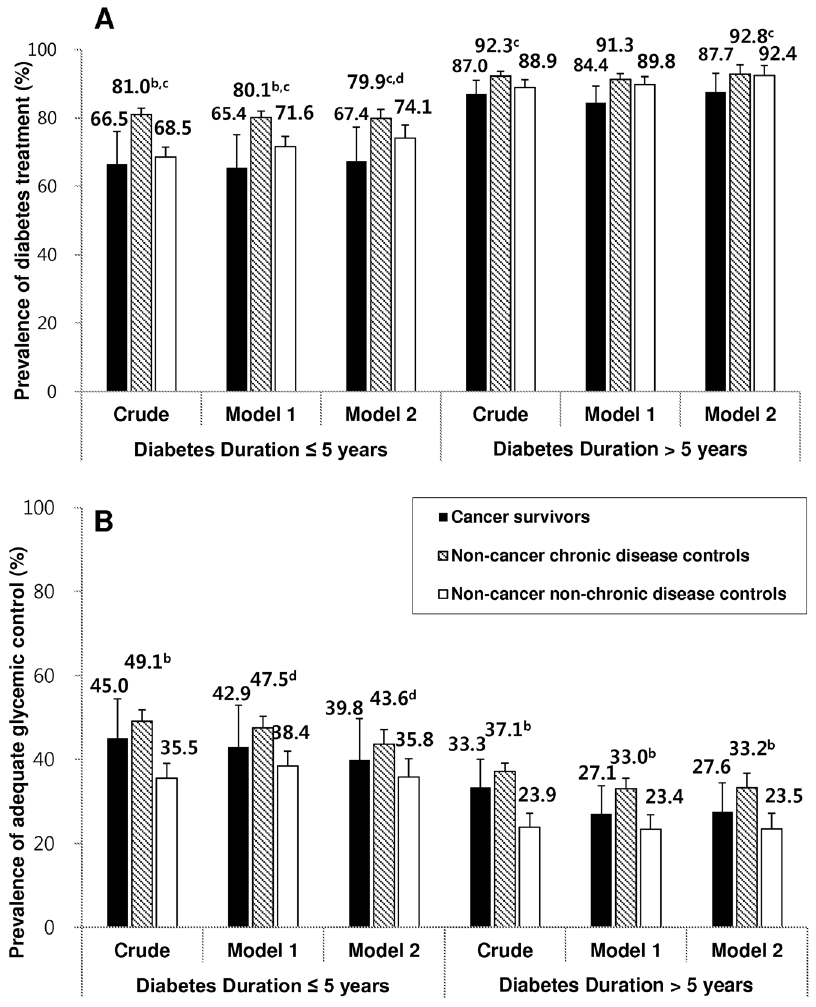
Figure 2. Prevalence of: (A) diabetes treatment; and (B) adequate glycemic control, among the cancer survivor and control groups with prevalent diabetes, according to diabetes duration. Model 1 was adjusted for age and sex; Model 2 was additionally adjusted for education and BMI. We adjusted for multiple tests by applying the Bonferroni method. a p -value , 0.05 when compared with cancer survivors. b p - value , 0.05 when compared with non-cancer non-chronic disease controls. c p -value , 0.15 when compared with cancer survivors. d p -value , 0.15 when compared with non-cancer non-chronic disease controls.